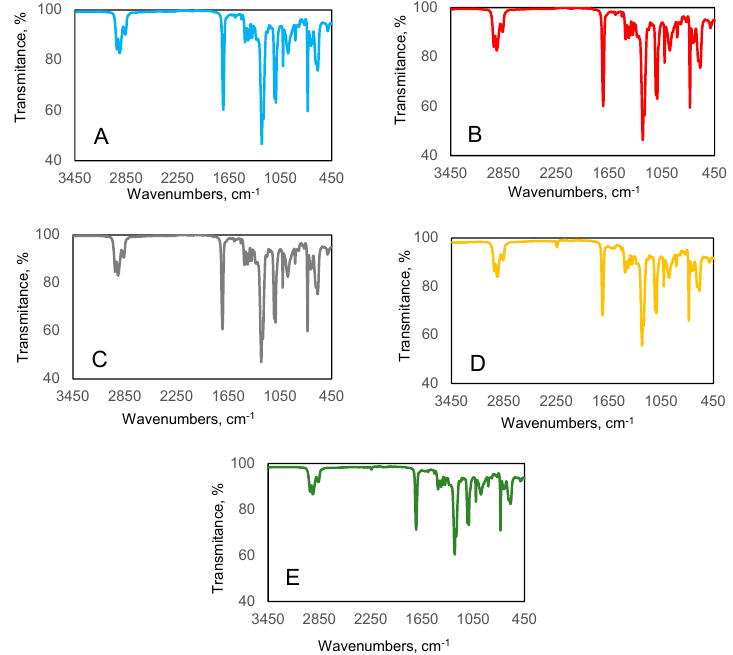
Figure 2. ATR-FTIR spectra of the tested polymer composites.